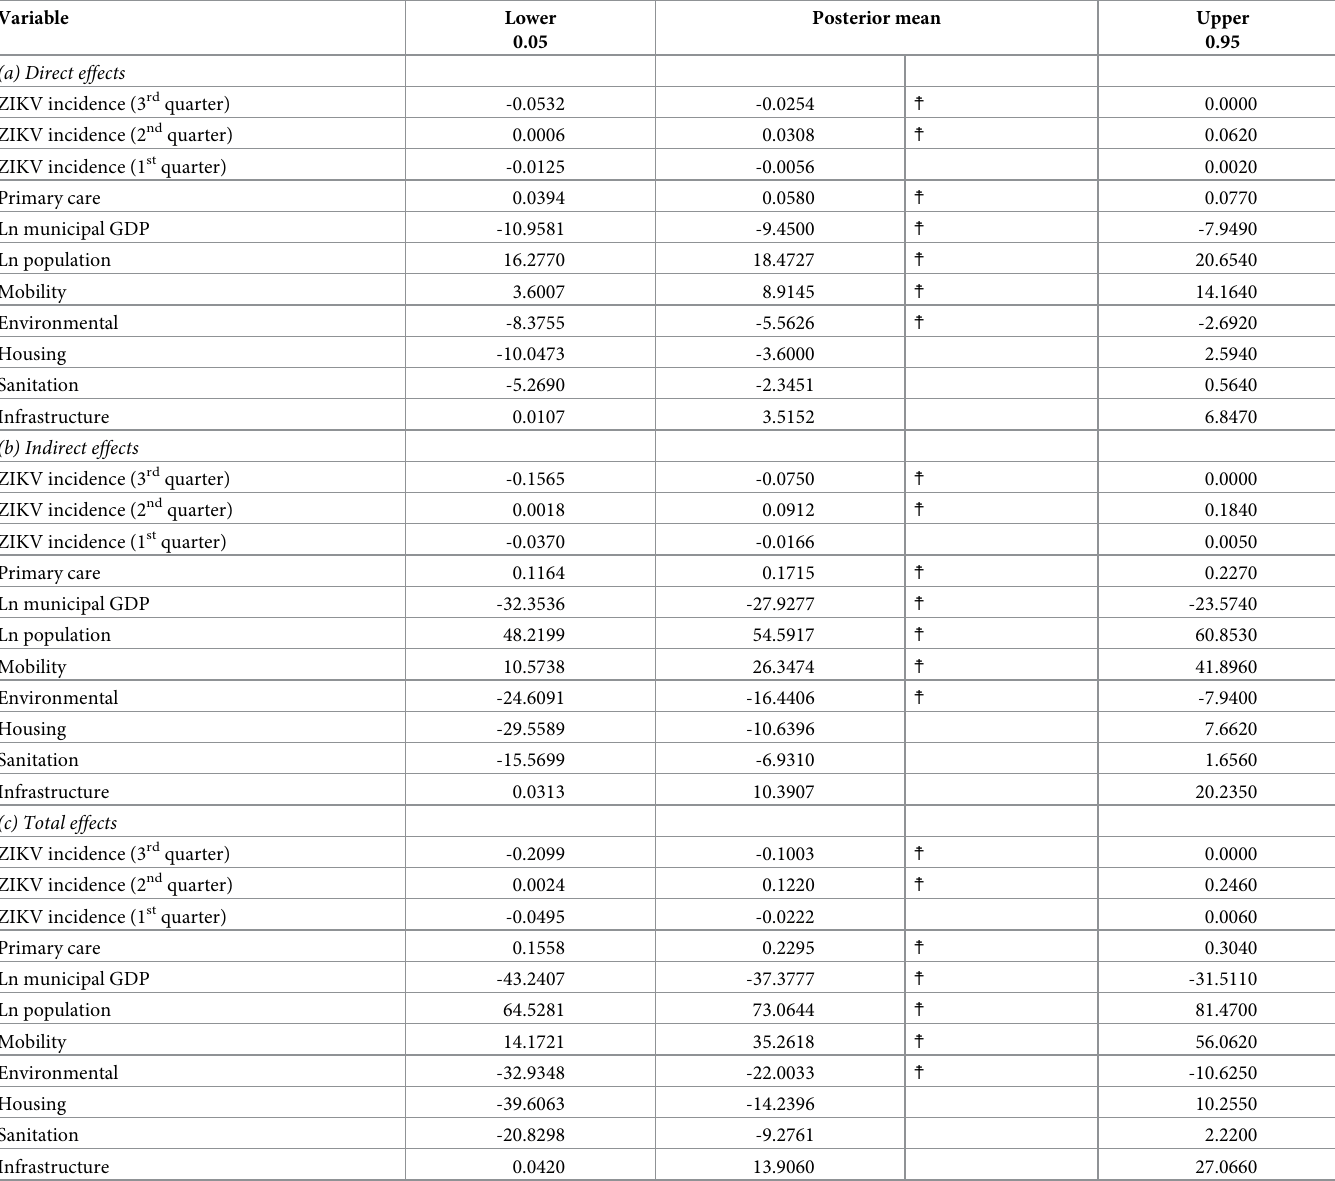
Table 4. Results of SAR Tobit—Direct and indirect effects—Dependent variable: Microcephaly incidence (4 th quarter), Brazil—2016.